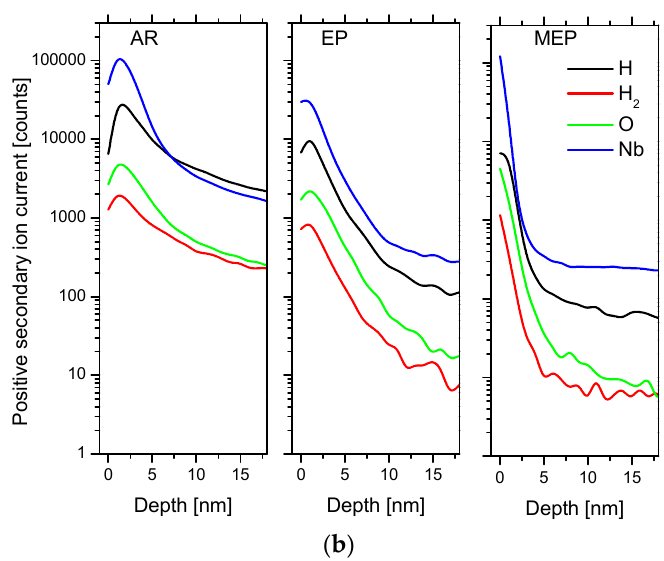
Figure 13. Results of secondary ion currents values dependent on the depth of ion etching in the range from top surface down to 17 nm in-depth: ( a ) rough data, and ( b ) smoothed plots: B-Spline.